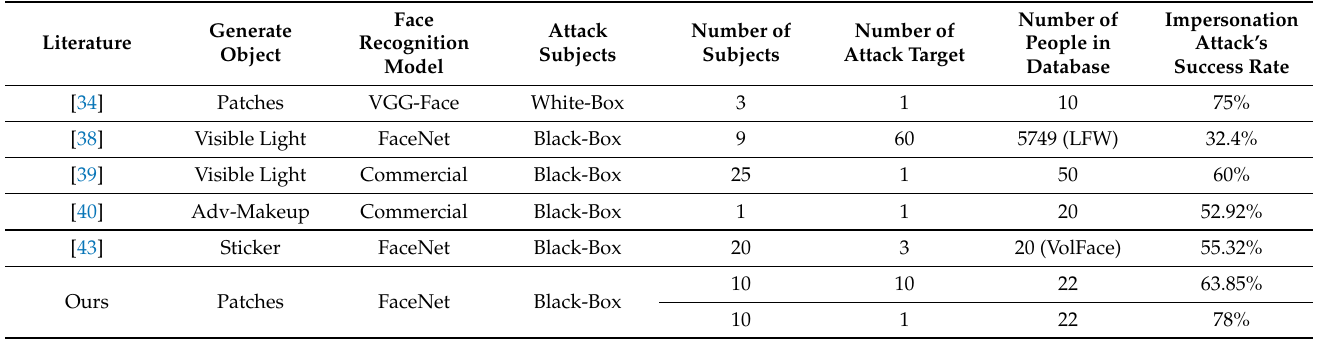
Table 14. Comparison of physical impersonation attack success rates of different